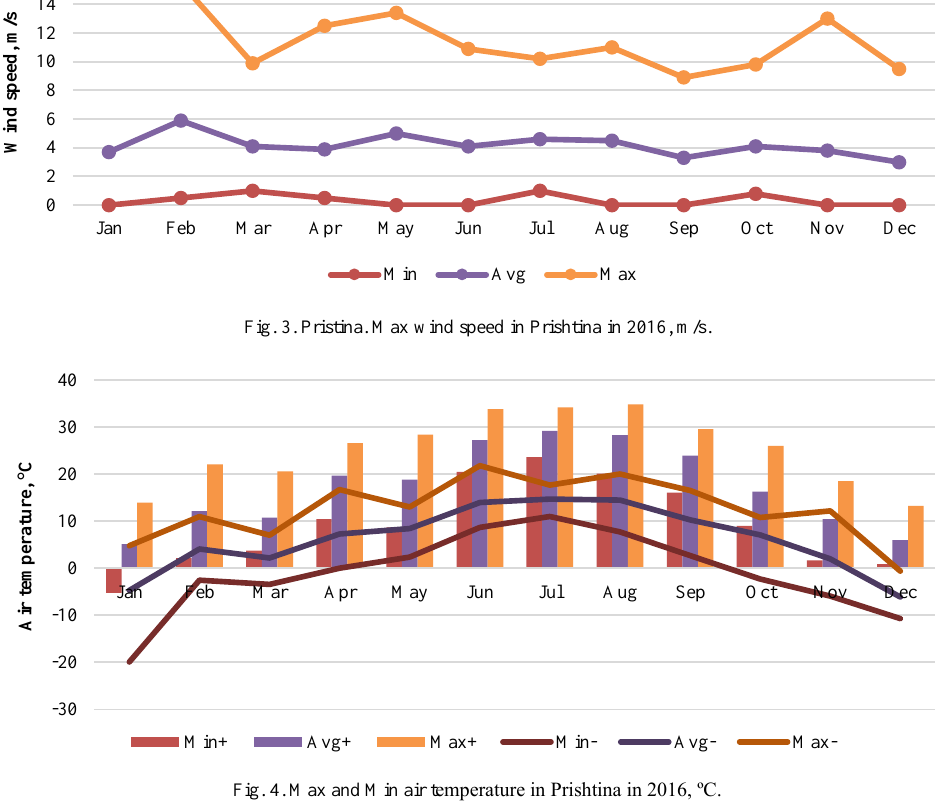
Fig. 4. Max and Min air temperature in Prishtina in 2016,